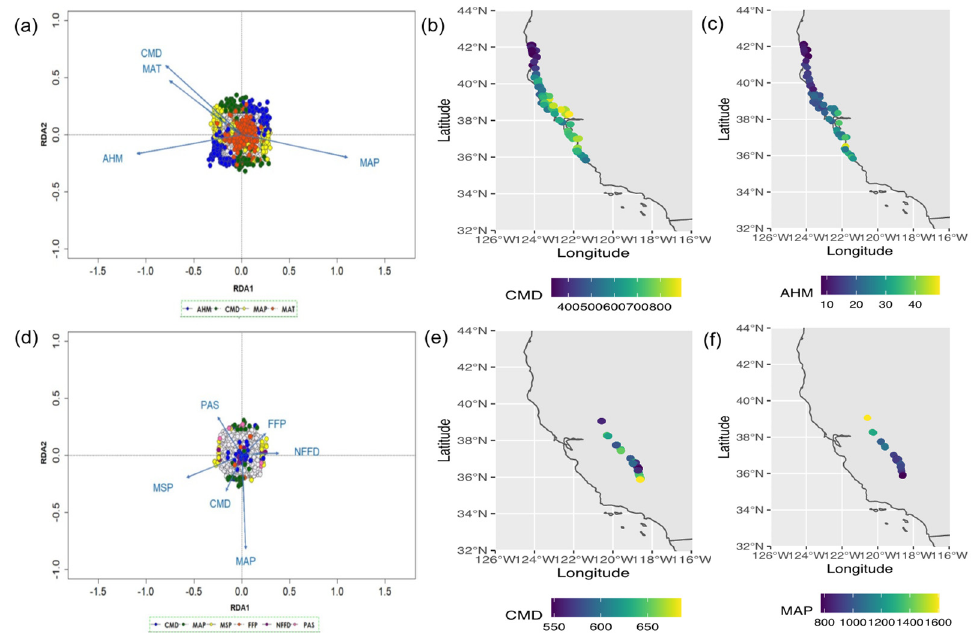
Figure 4. Results of multivariate RDA and distribution maps of environmental variables. Data triplots to highlight SNP loadings on RDA axes 1 and 2 ( a ) in SESE and ( d ) in SEGI. Candidate SNPs are shown as colored points with coding by most highly correlated environmental predictors. SNPs not identified as candidates (neutral SNPs) are shown in light gray. Blue vectors represent environmental predictors. Distribution maps of climate moisture deficit (CMD) and annual heat moisture index (AHM) across collected samples are displayed in ( b ) and ( c ), respectively, for SESE. CMD and mean annual precipitation (MAP) distribution maps are displayed in figures ( e ) and ( f ), respec- tively.